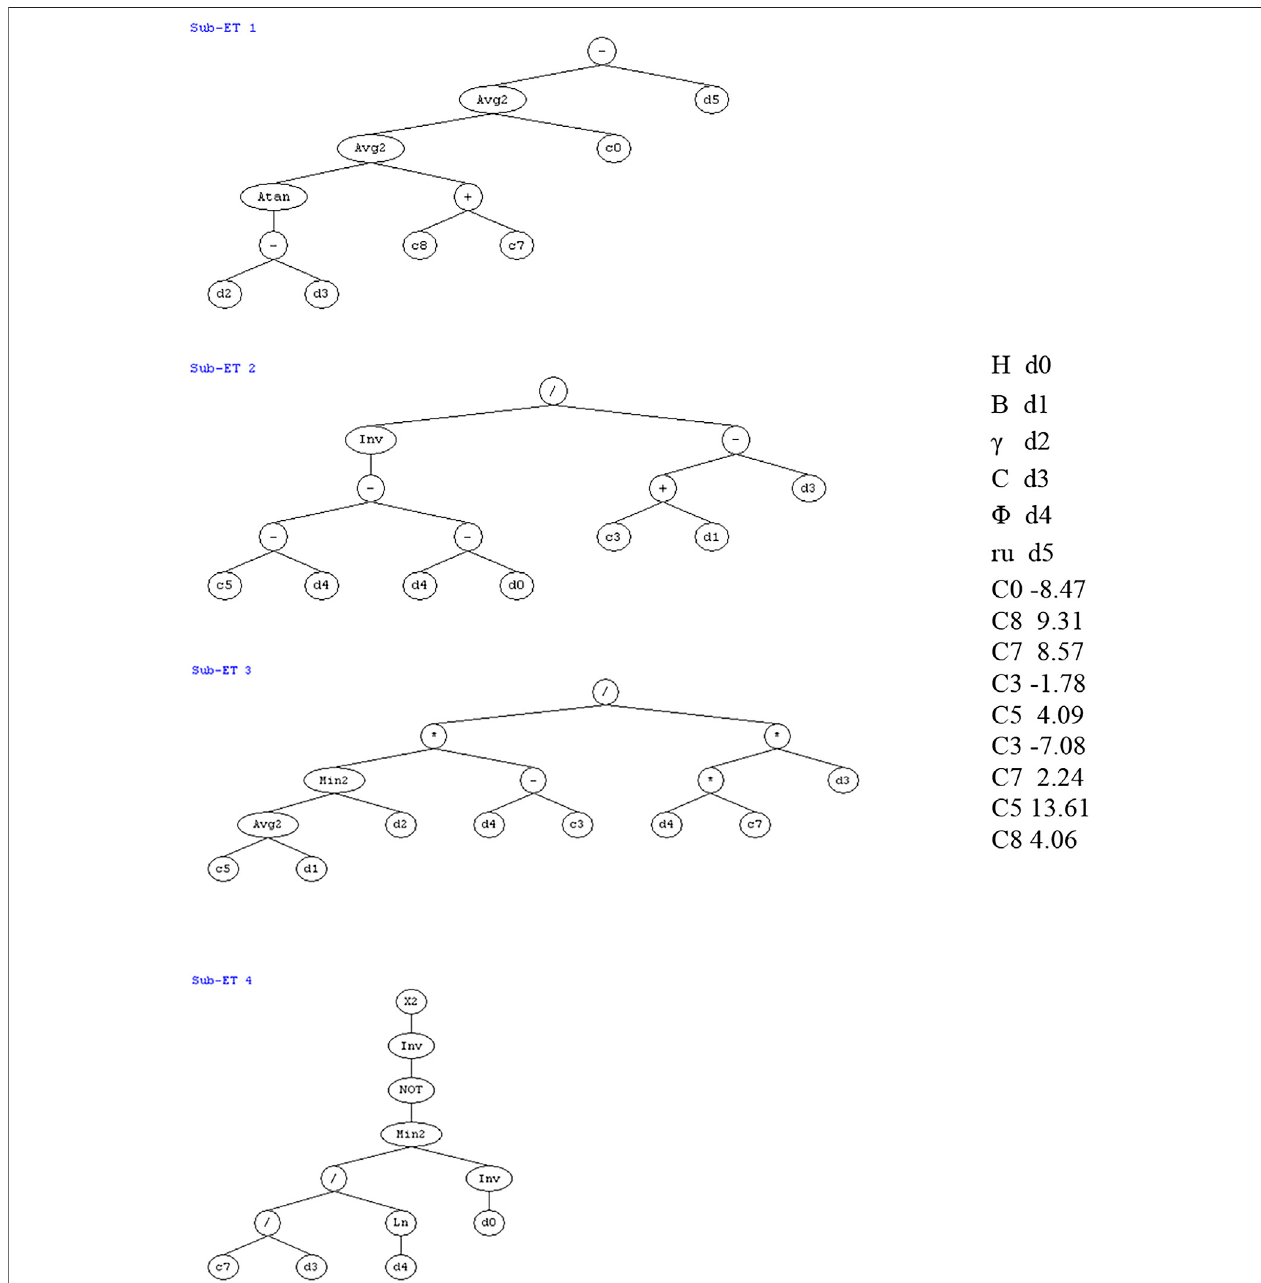
FIGURE 4 | Tree Expression to predict factor of